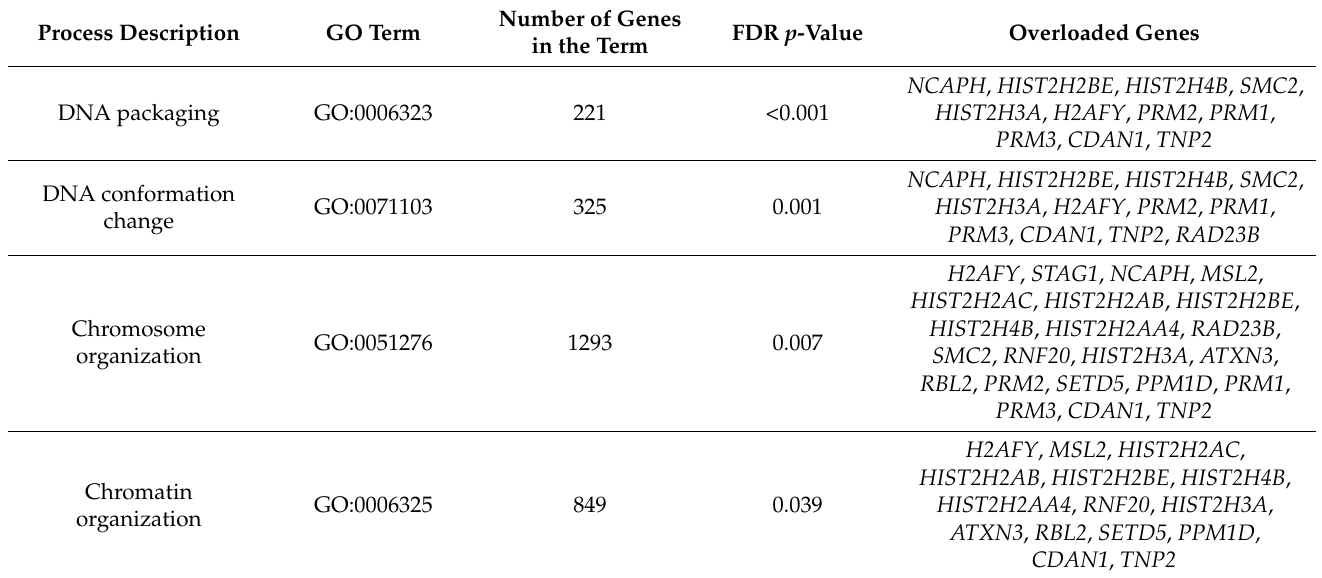
Table 3. Enrichment analysis results obtained with the ShinyGO v0.61